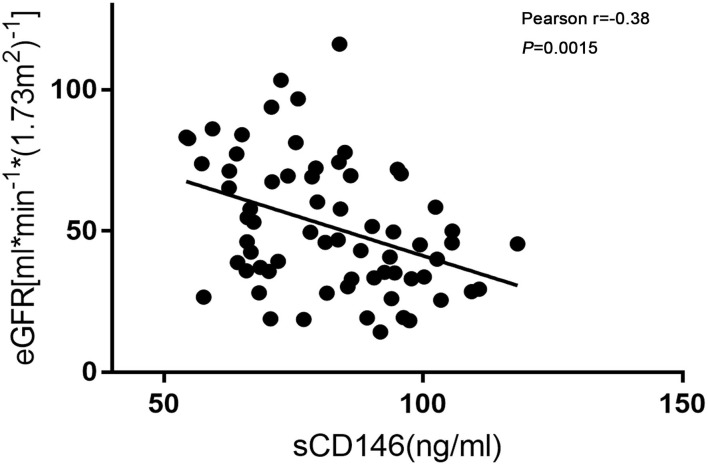
Correlation of sCD146 and eGFR. Soluble CD146 was negatively correlated with eGFR. Pearson r = −0.38, P = 0.0015.